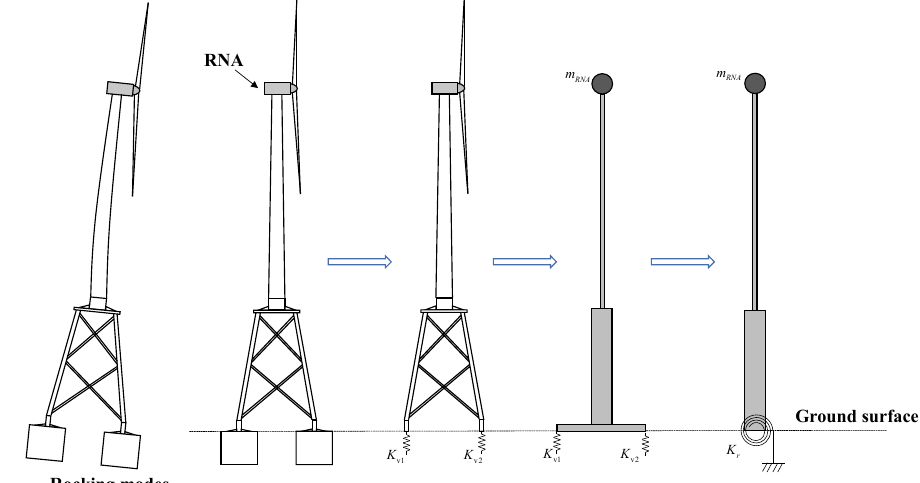
Figure 19. Sharing of soil rotational resistance in the anti-overturning bearing capacity: ( a ) sand, ( b ) soft clay.